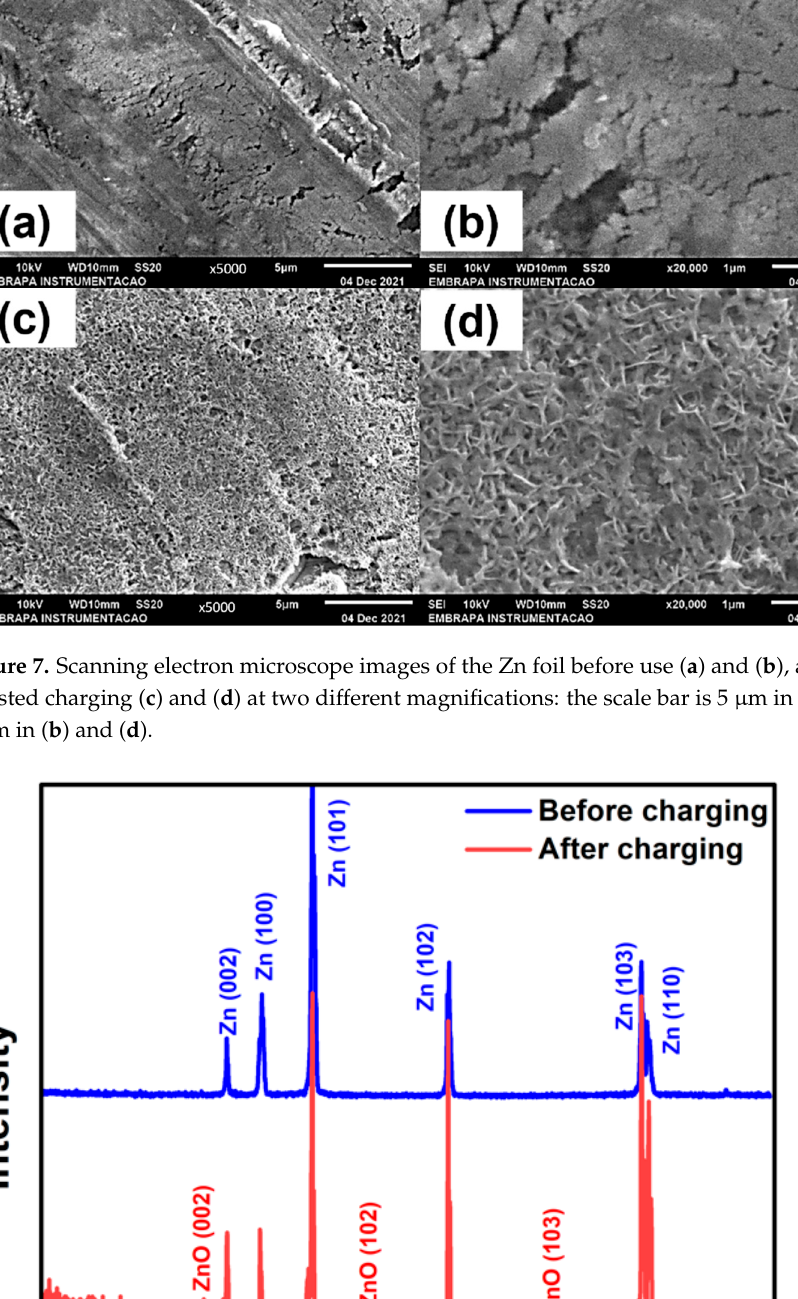
Figure 8. X-ray diffraction patterns for Zn foil before and after charging.